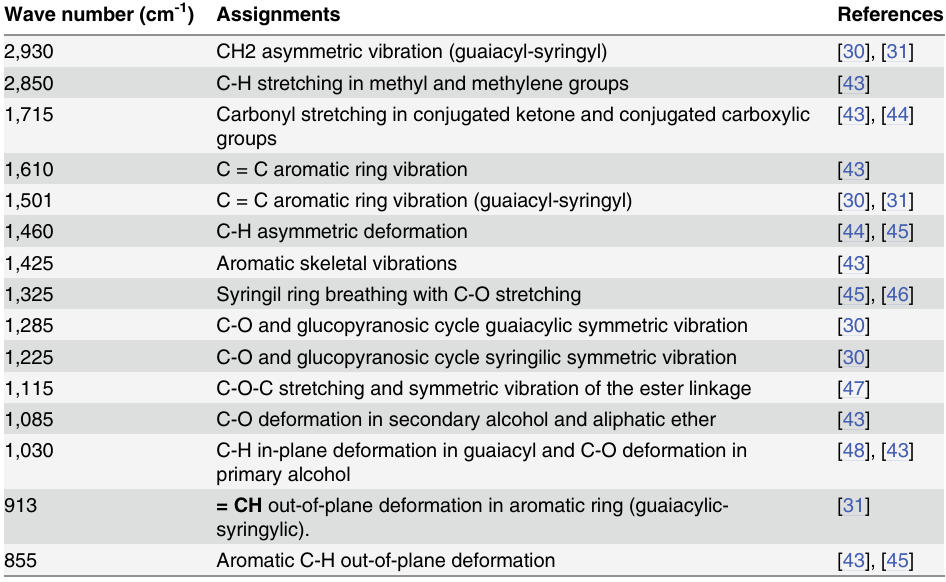
Table 3. Assignment of FTIR absorption bands in wood